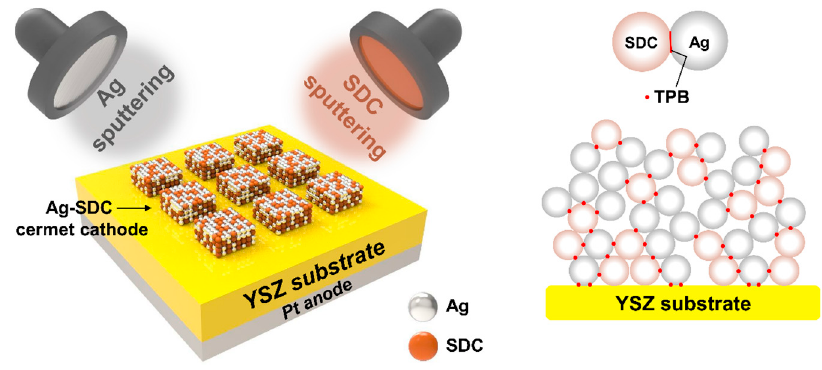
Figure 1. Co-sputtering process for Ag-SDC cermet cathodes.